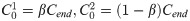
Analysis of protein dynamics based on experimental and simulation data.(A) Schematics of the model. In the population, each cell is characterized by seven parameters. At division, the parent-cell mass (Cend, Gend) is randomly split between the two progeny cells, according to the expression C01=βCend,C02=(1−β)Cend in which β is the random variable. Cell-cycle phase durations (TG1i,TG1i) for progeny cells (i is progeny number) are calculated using autoregression bifurcating models. pCi,pGi—production rate of Cdt1 and Geminin proteins, are calculated using linear regression models, TCi—cell cycle duration, TG1,TSG2M—G1 or S/G2/M phases length of the parent cell, μG1,μSG2M–mean G1 or S/G2/M cell cycle phases length, θG1,θSG2M–relation between parent and progeny G1 or S/G2/M cell cycle phases length, WG1i,WSG2Mi – random variables from bivariate lognormal distributions (common mean zero, common variances and correlation coefficients). We abandoned the originally assumed bivariate normal distribution to lognormal because of the positive skewness of the distributions of cell-cycle duration. (B) Comparison of linear relationships between the total division time and the duration of phases for experimental and simulation data. Solid black lines show the fitted linear relations of the form y = (slope) × x. (C) Comparison of distributions of the cell cycle and the cell-cycle phase duration for experimental data and modelling results. (D) Looking for probable regulatory mechanisms. Data-derived and simulation-based correlations between pairs of variables characterizing the protein trajectories. (E) Data-derived and simulation-based correlations between production parameters of family members.